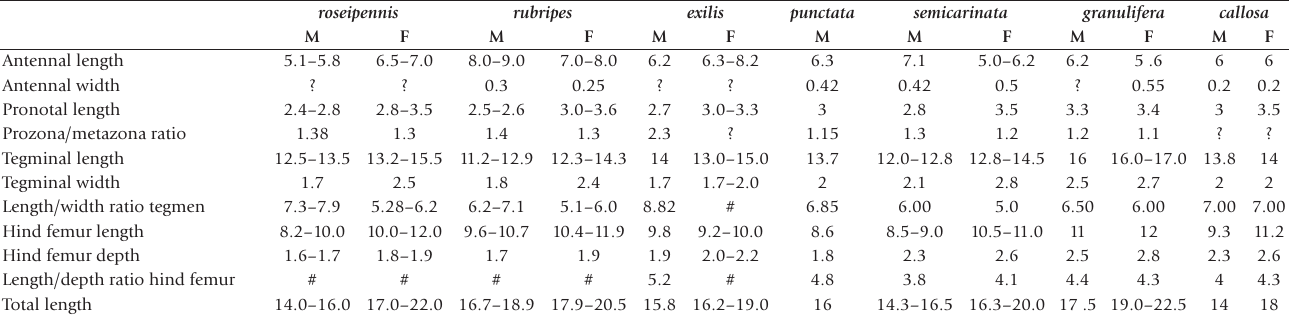
Table 4. Measurements of Sumba species